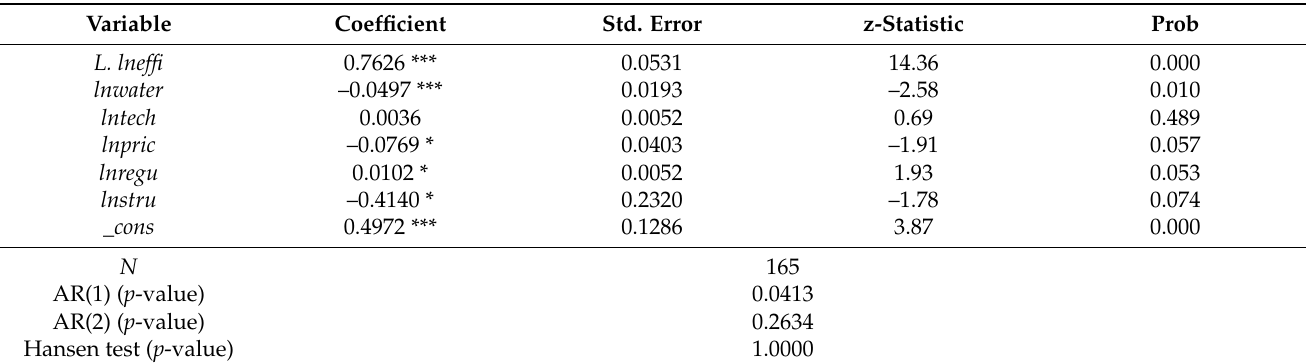
Table 4. Estimation results of the dynamic panel system generalized method of moments (GMM)